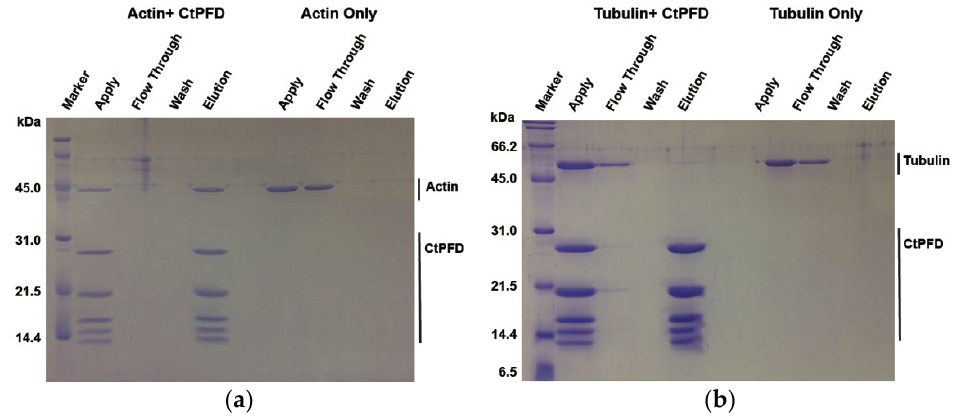
Figure 5. Interaction of CtPFD with substrate proteins. SDS-PAGE of the pull-down assay for the interaction between CtPFD immobilized on StrepTrap HP column with actin ( a ) and tubulin ( b ).